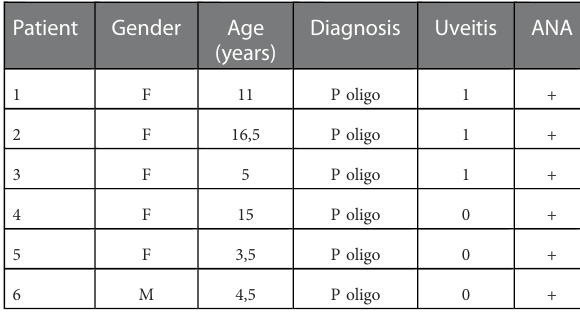
TABLE 1 Description of patients in plasma pools.